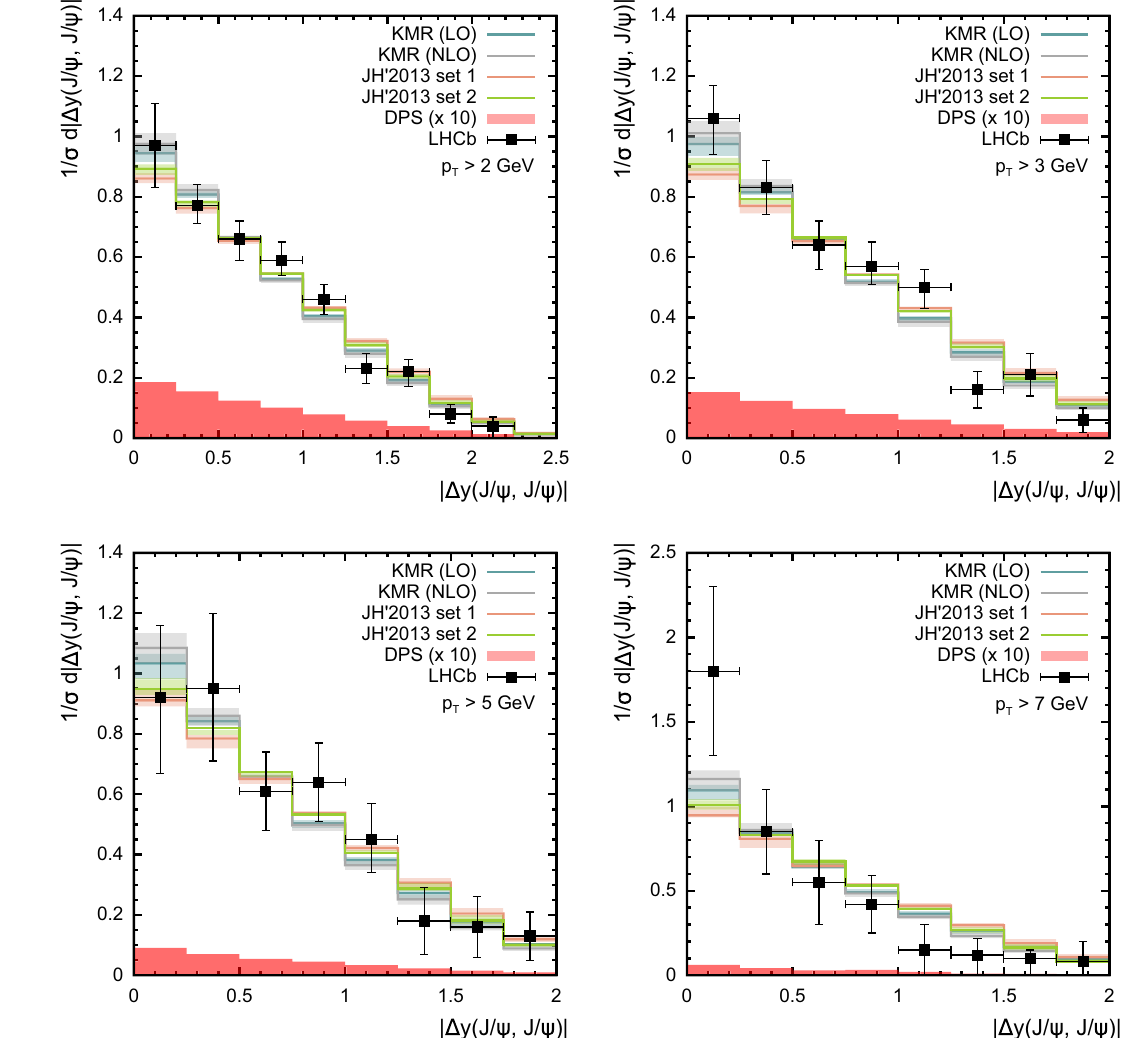
√ s = 8 TeV as a function of the difference in the